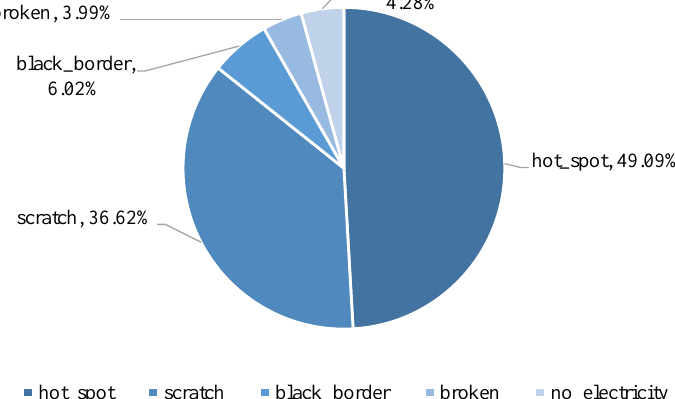
Figure 5. PV Multi-Defect dataset annotation